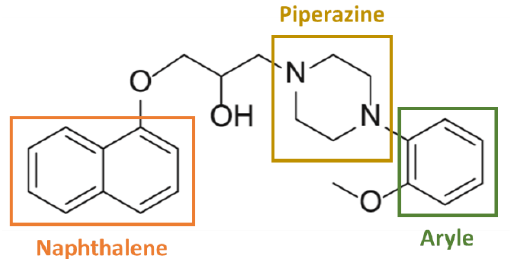
Figure 1. Chemical structure of naftopidil (according to [65,71,75]). Naftopidil is an aryl-piperazine based α 1-AR antagonist possessing a naphthalene group.